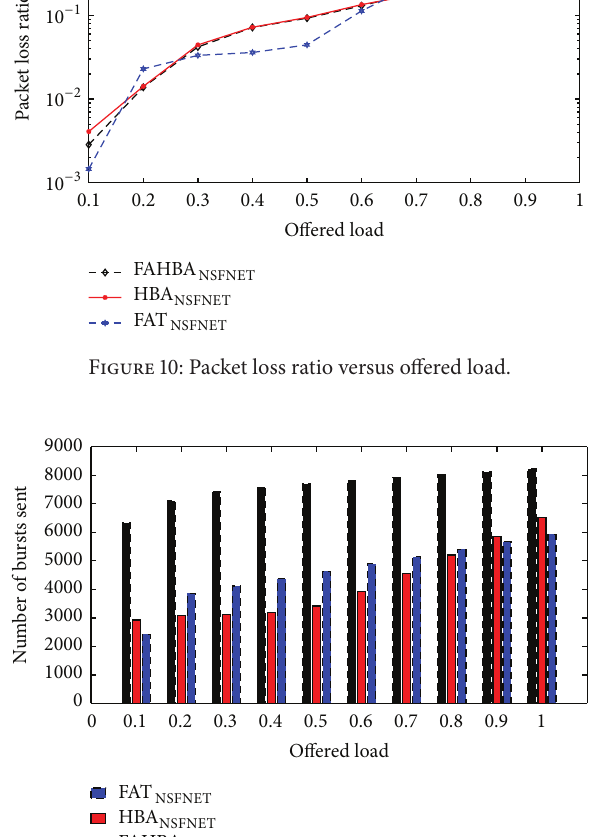
fewer bursts were generated and sent into the network. In the case of HBA, the thresholds are